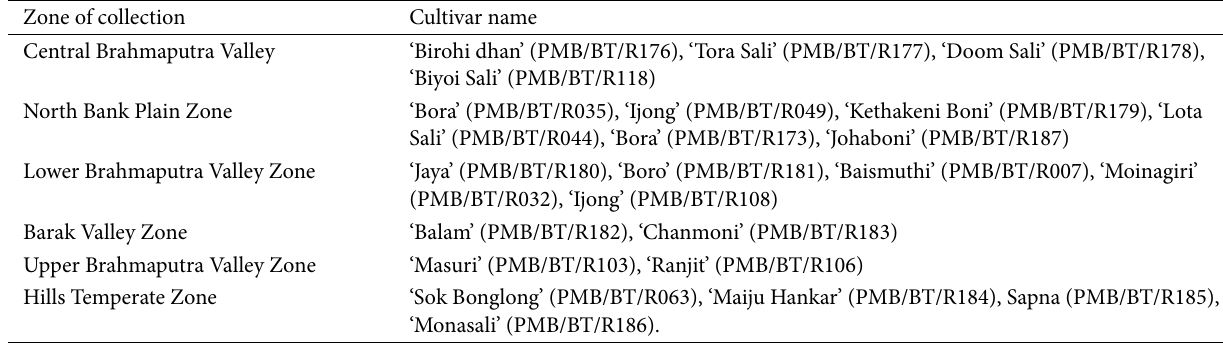
Table 1 Collected rice cultivars, assigned laboratory codes, and collection zones. Zone of